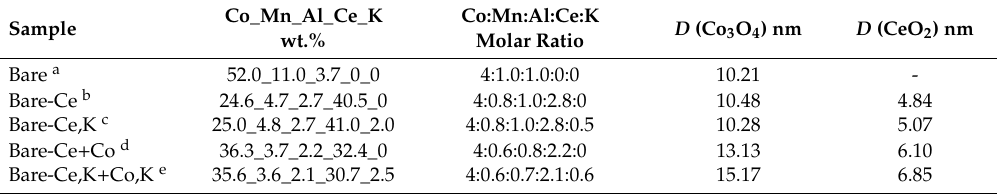
Table 1. Chemical analysis and XRD characteristic values of the bare and modified Co-Mn-Al catalysts.